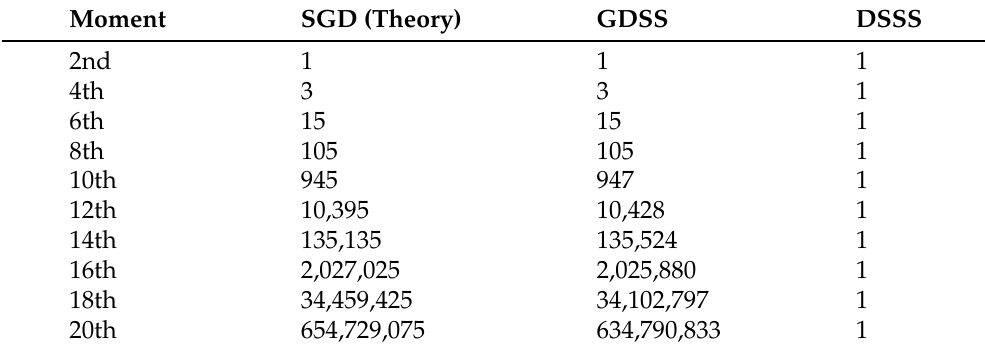
Table 1. Moments of GDSS noise-free signal for N =